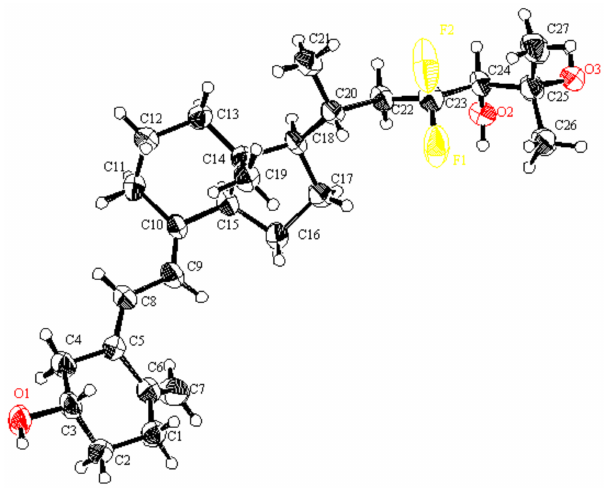
Figure 3. ORTEP drawings of 7 ; Ellipsoid contour probability level = 50% (CCDC 2202393). The triene structures were constructed using 8-keto-CD-rings ( 32 , 35 , 36 ) and the A- ring ( 14 ). The 8-keto-CD-ring ( 32 ) was synthesized via the oxidation of 9 and subsequent protection of the C25-OH group with TES. For the synthesis of the 8-keto-CD-rings ( 35 , 36 ), both C24 and C25 hydroxy groups of 10 and 11 were protected with p -methoxybenzylidene acetal that provided inseparable diastereomeric mixtures, respectively, followed by ox- idation of the C8-OH group using TPAP/NMO to generate 35 and 36 (Scheme 7). The coupling reaction between the 8-keto-CD-rings ( 32 , 35 , 36 ) and A-ring phosphine oxide ( 14